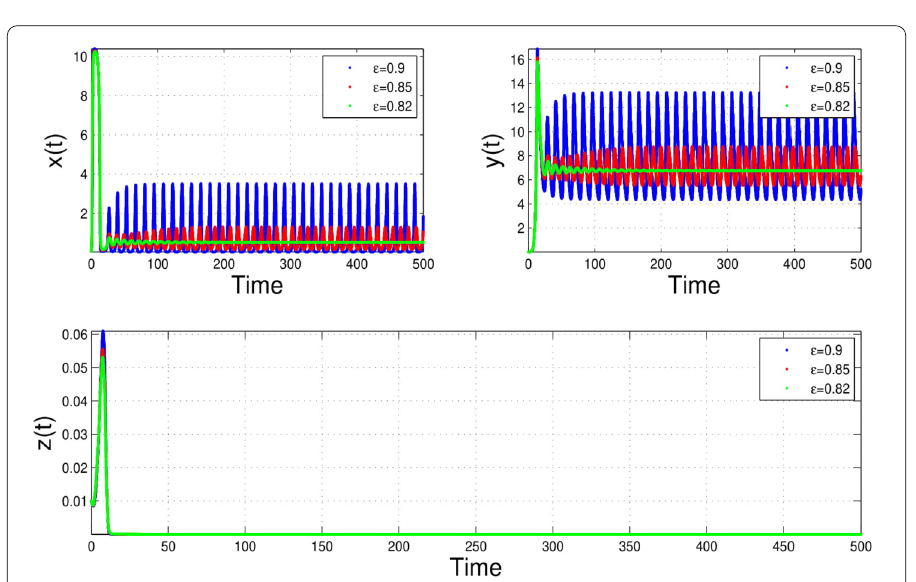
Figure 4 The memory effect on the stability of the SPFE